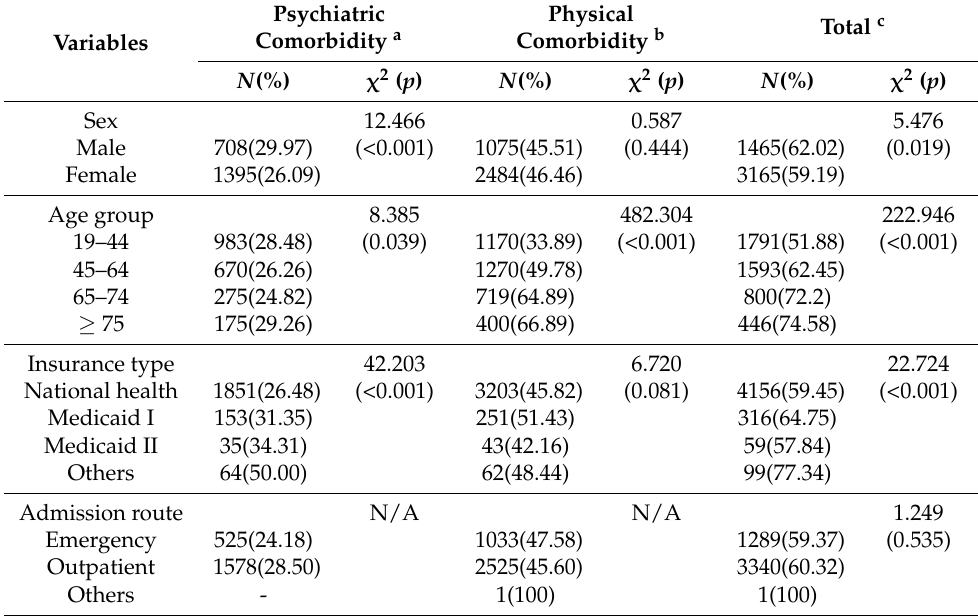
Table 1. General characteristics of study population and prevalence of